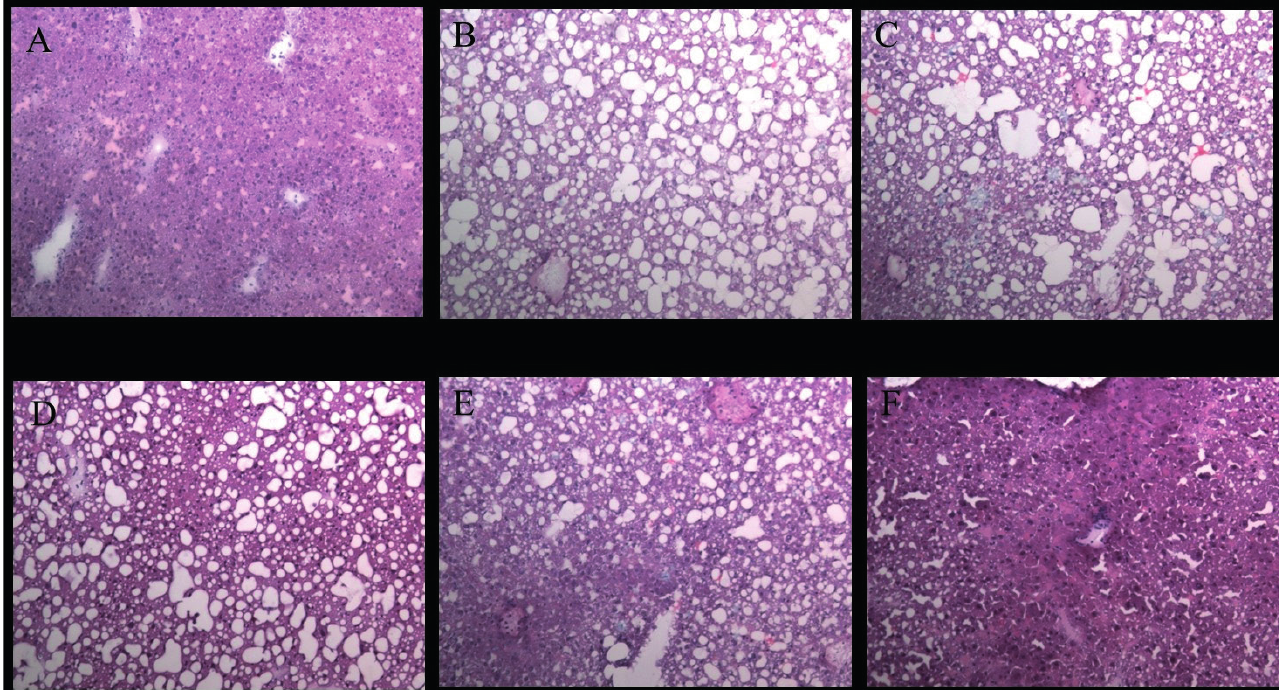
staining at a magnification of ×100. A. blank control group, B. Model control, C. positive control, D. ZS group, E. F1 group, F. F2